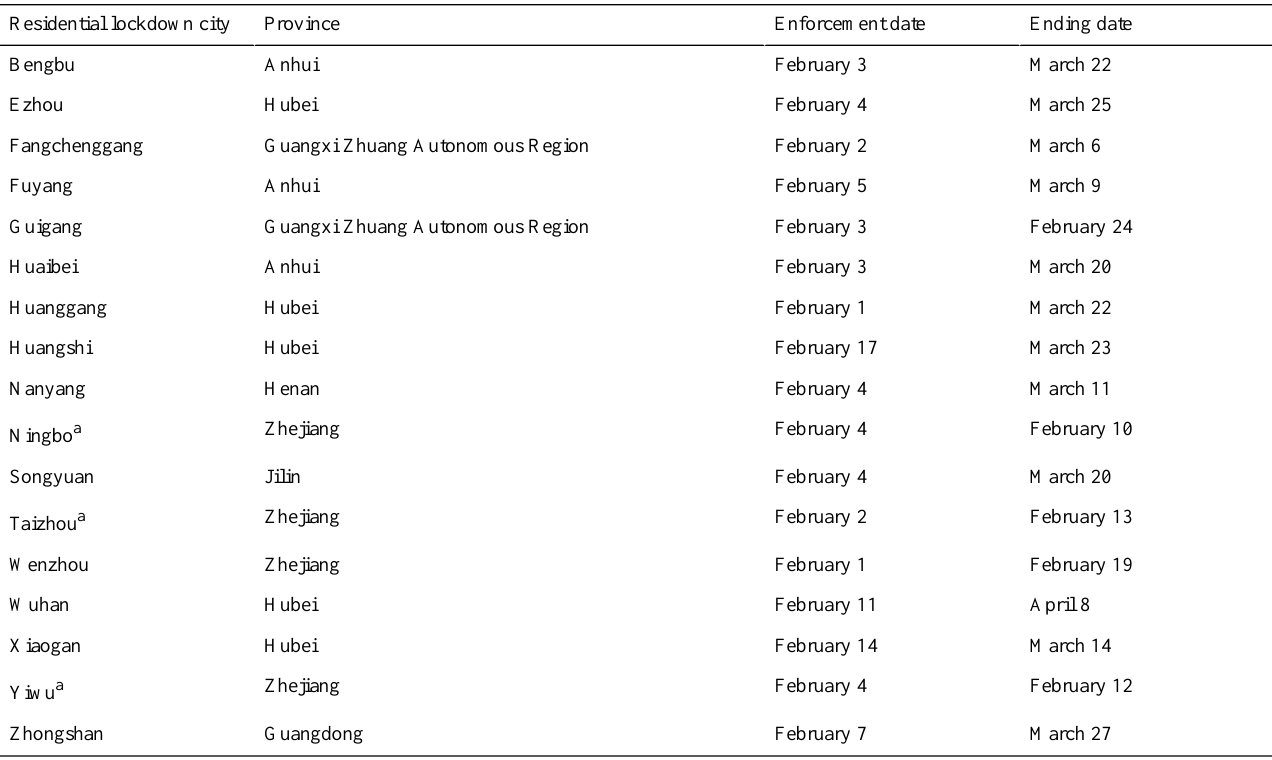
Table 1. Residential lockdown cities and their enforcement and ending dates (in